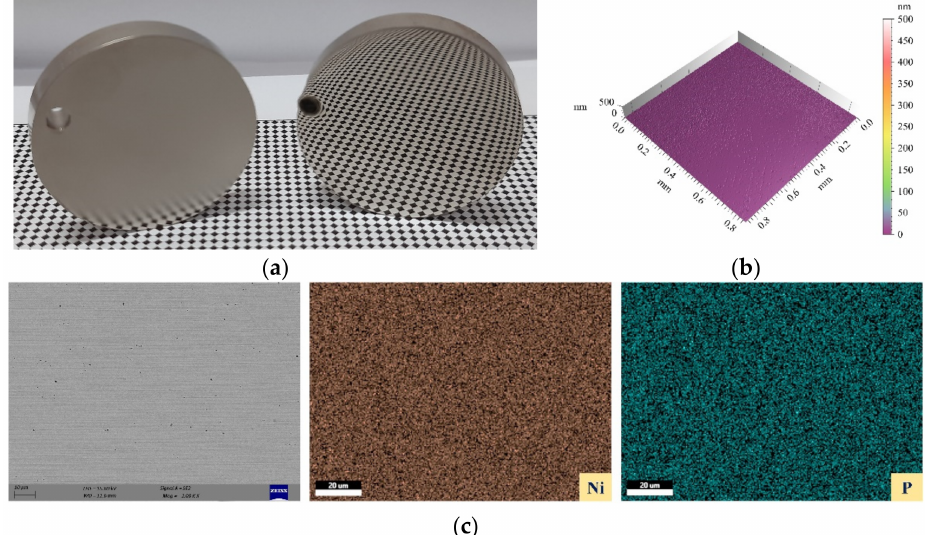
Figure 17. ( a ) Actual photograph of as-plated and nano-finished surfaces, ( b ) 3D surface profile of finished surface, and ( c ) SEM micrograph and elemental area mapping of finished